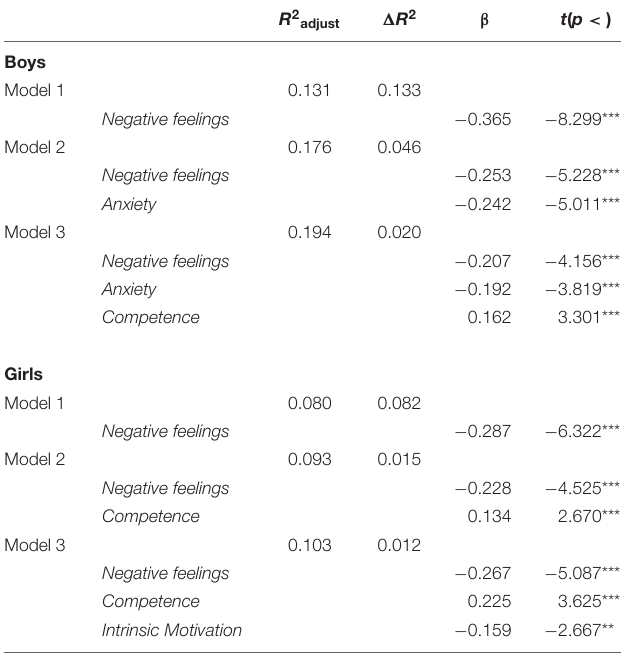
TABLE 2 | Explained variance ( R 2 ), change in R 2 ( (cid:49) R 2 ), regression coefficients ( β ), and associated statistical significance [ t ( p < )] in the prediction of boys’ and girls’ mathematics